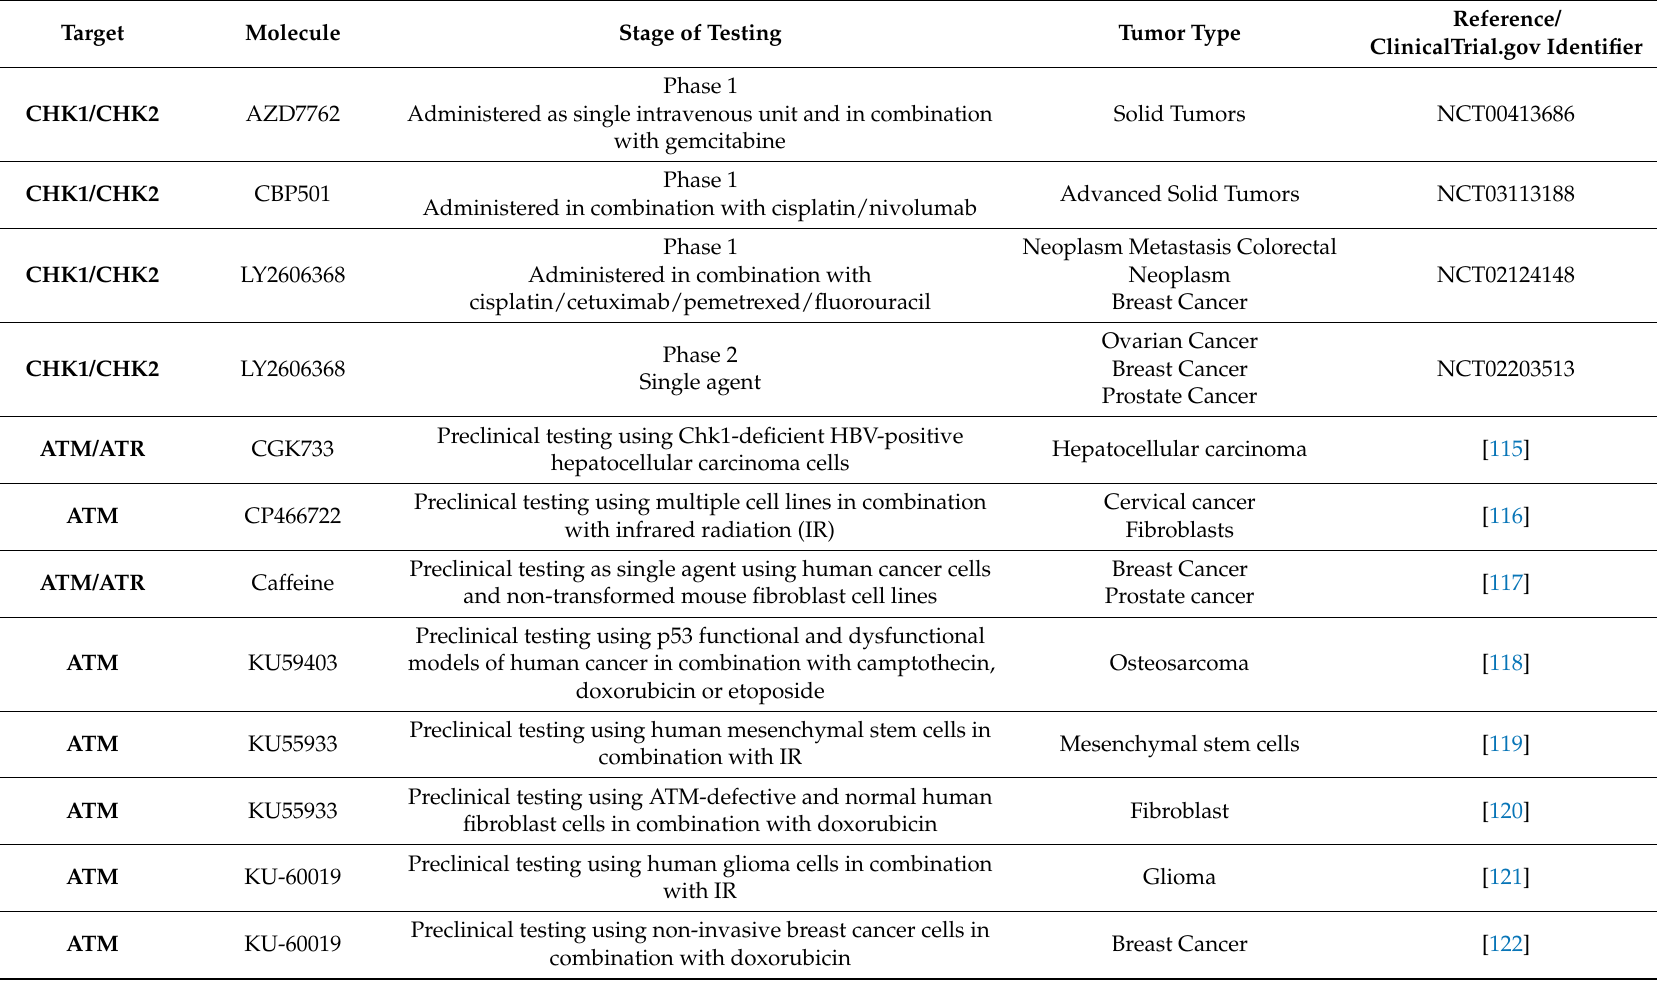
Table 1. Small molecule inhibitors of ATM-CHK2 Kinases in preclinical or clinical development for cancer